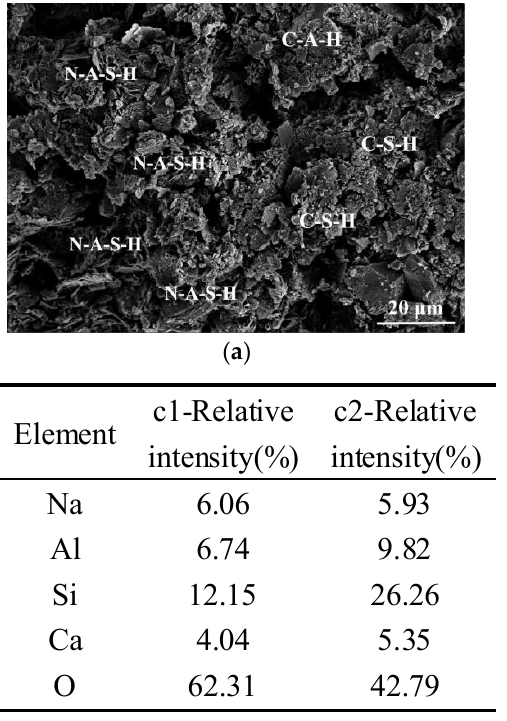
( d ) Figure 7. SEM images of II-3: ( a ) and ( b ) 7 d; ( c ) EDS result—7 d; ( d ) 28 d. As shown in Figure 8, compared with C-2, a large number of three-dimensional net- work products and voids are observed in the SEM image of II-5. Combined with subse- quent EDS analysis, the gelatinous products can be qualitatively analyzed. The EDS result in Figure 8c shows that the geopolymer gel (point c1) is a coexistence composed of N-A- S-H and C-S-H. The main components of the gelatinous product at point c2 are Na, Al, and Si elements, which confirms that the network product is the N-A-S-H gel under a low- calcium system. The increase in the amount of N-A-S-H gel produced is positively corre- lated with the increase in fly ash content in II-5 [52]. It can be observed from Figure 8a,b that this stable three-dimensional network structure hinders the secondary reaction be-